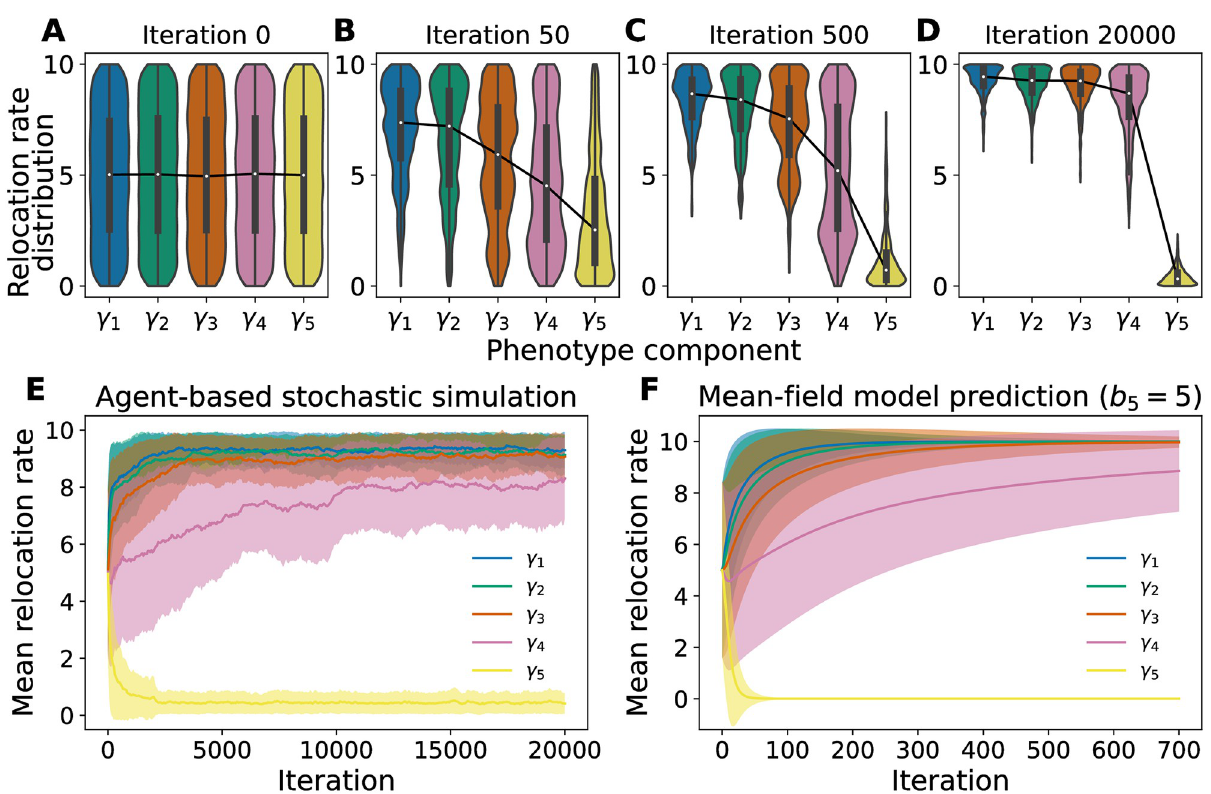
Fig 2. Emergent competitive phenotypes from evolutionary birth-death dynamics. A - D . Violin plots of distributions of phenotype components in the agent-based stochastic simulations at iterations 0, 50, 500, and 20000, respectively. Each violin plot combines data from 20 independent trials. The connected white dots are the median values of each relocation rate component, and the black boxes confine the first and third quartiles of each phenotype component (i.e., box plot). The colored areas are the kernel density estimations of the underlying distributions. Panel A shows a uniform relocation rate distribution for each phenotype component as the initial condition at iteration 0. The phenotype distributions evolve as the birth-death dynamics play out in the agent-based model and approach a steady shape after around 20000 iterations as shown in panel D. E The evolutionary trajectory of each phenotype component, averaged over 20 independent trials. The shaded area represents the standard deviations of phenotype components. The stochastic birth-death dynamics selects out competitive phenotypes whose first three phenotype components γ 1,2,3 saturate at hopping rate of around 9, close to the maximum possible hopping rate of γ max = 10, and whose last phenotype component γ 5 saturates at hopping rate around 0.5, close to the minimum possible hopping rate of γ min = 0. In contrast, the fourth component γ 4 approaches a value around 8 with a relatively large variability throughout the simulation. F. Predictions of the mean relocation rate of each phenotype component and their standard deviations using the coupled 5-state mean-field model, discussed in A minimal mean-field model explains variability in competitive phenotypes. Note that the mean-field model uses a slightly different birth rate b 5 = 5, while the stochastic simulations use b 5 = 4, and the 5-state mean-field model converges at a much shorter timescale (700 iterations vs. 20000 iterations). These quantitative differences between the full agent-based model and the simplified 5-state model are discussed in detail in the Discussion, S5 and S6